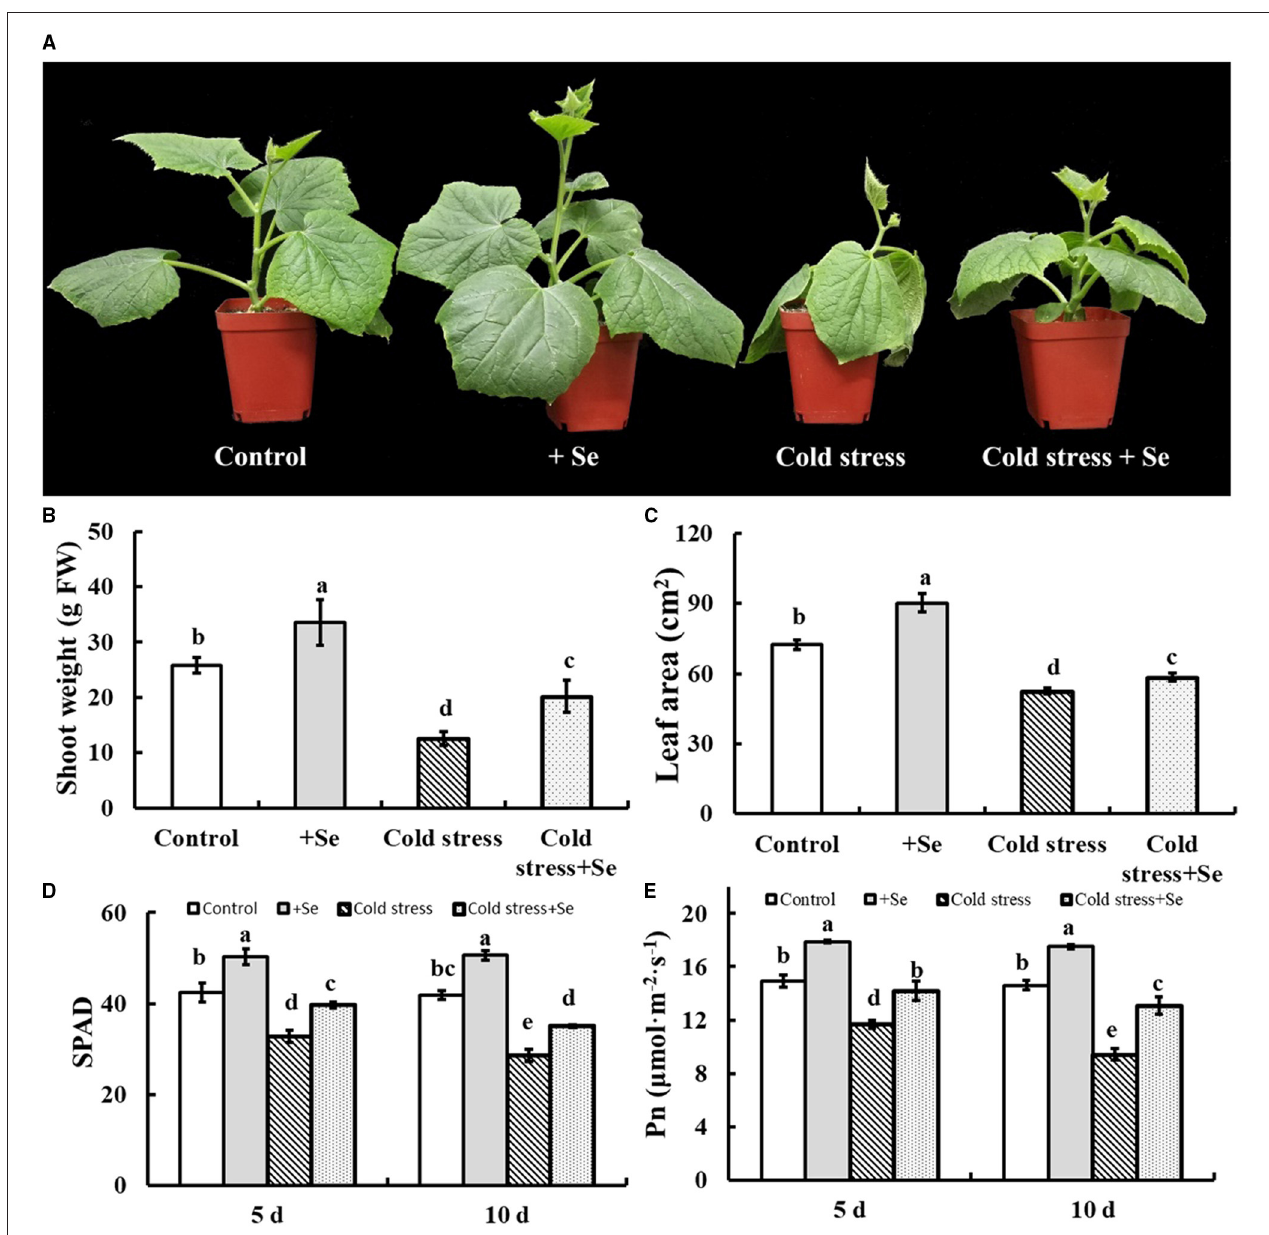
FIGURE 2 | Effects of exogenous selenium on cold stress of cucumber seedlings. (A) The phenotype of control, selenium application, cold stress, and selenium application under cold stress. (B) Shoot weight of control, selenium application, cold stress, and selenium application under cold stress. (C) Leaf area of control, selenium application, cold stress, and selenium application under cold stress. (D) SPAD value of control, selenium application, cold stress, and selenium application under cold stress with 5 and 10 days treatments, respectively. (E) Net photosynthetic rate of control, selenium application, cold stress, and selenium application under cold stress with 5 and 10 days treatments, respectively. Values are expressed as means of three replicates ± SD, and different letters are significantly different ( P <